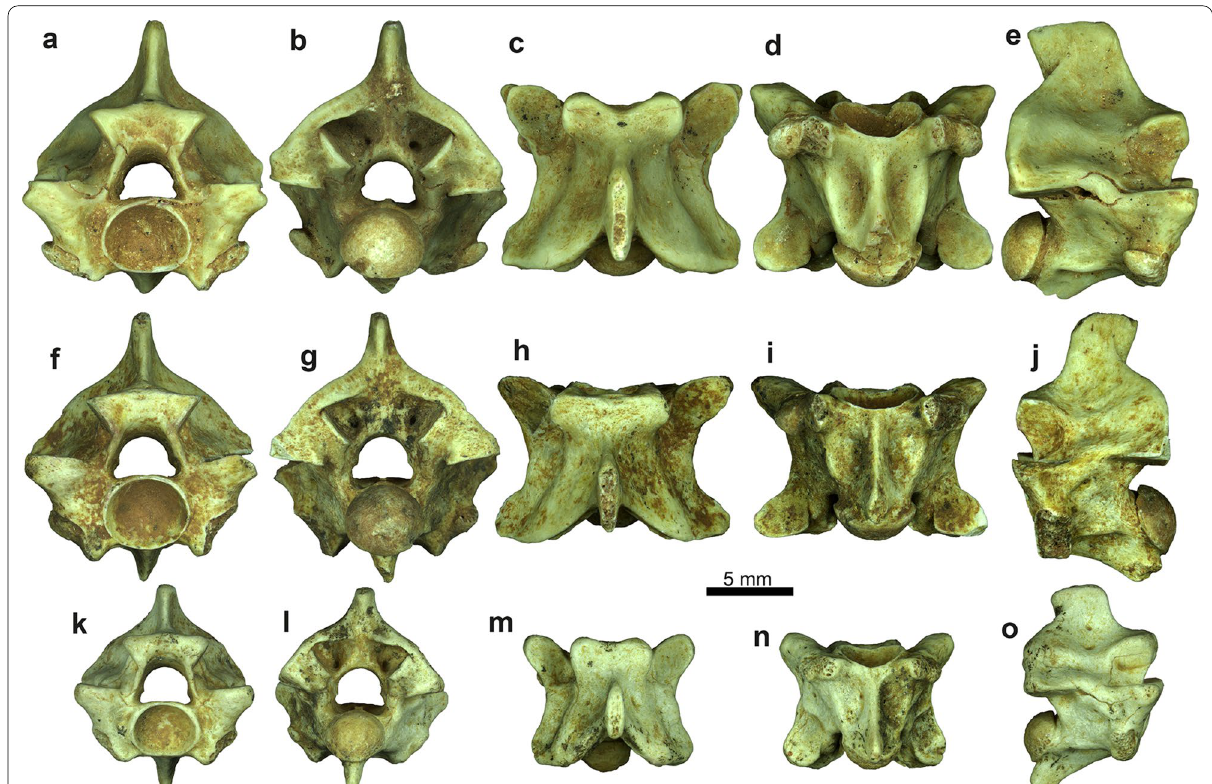
Fig. 79 Phosphoroboa filholii comb. nov. from imprecisely known locality(ies) in the Phosphorites du Quercy: a – e anterior trunk vertebra (NHMW 2019/0033/0077) in anterior ( a ), posterior ( b ), dorsal ( c ), ventral ( d ), and right lateral ( e ) views; f – j anterior trunk vertebra (NHMW 2019/0033/0044) in anterior ( f ), posterior ( g ), dorsal ( h ), ventral ( i ), and left lateral ( j ) views; k – o anterior trunk vertebra (NHMW 2019/0033/0041) in anterior ( k ), posterior ( l ), dorsal ( m ), ventral ( n ), and right lateral ( o )